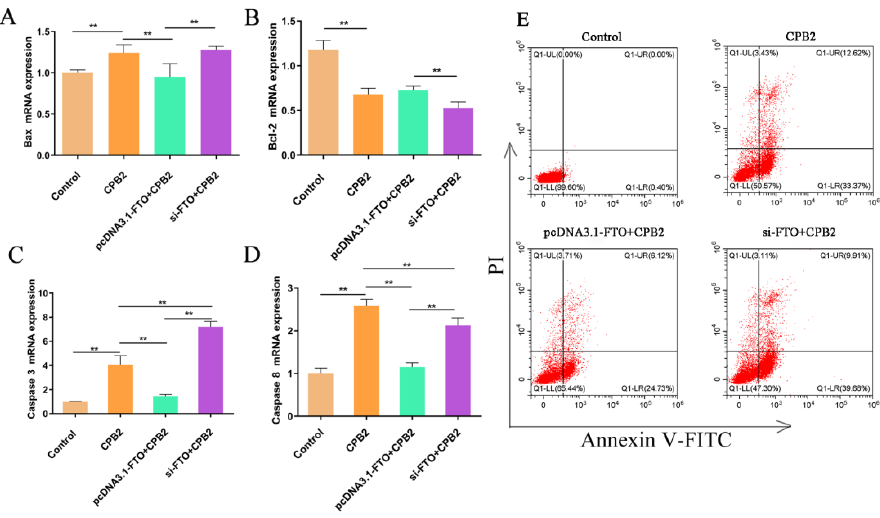
Figure 5. The effect of FTO on apoptosis in CPB2-treated IPEC-J2 cells. mRNA expression of Bax ( A ), Bcl-2 ( B ), caspase 3 ( C ), and caspase 8 ( D ) in cells treated with 20 µ g/mL for 24 h. Flow cytometry analysis of apoptosis in FTO-overexpressing or silenced cells treated with CPB2 ( E ). * p < 0.05; ** p < 0.01.